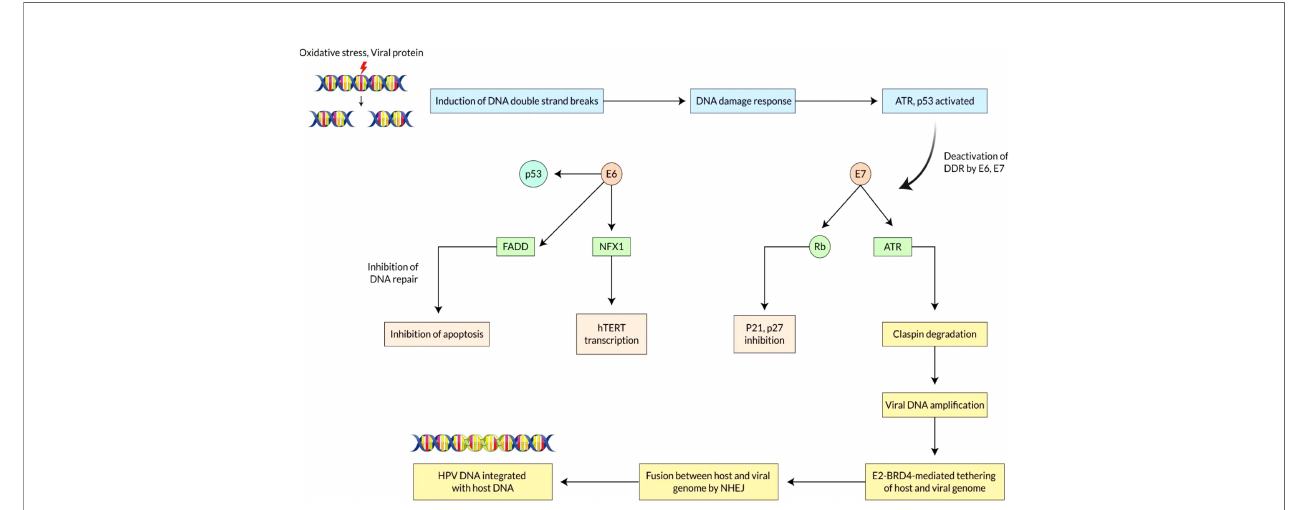
FIGURE 3 | Mechanisms of E6 and E7 overexpression due to integration of Human Papilloma Virus in Vaginal cancer. Vaginal cancer is a multi-stage process that is developed by the accumulation of DNA changes of host cell genes. Integrating HPV DNA into the host cell genome is crucial, resulting in abnormal proliferation and development. E6 and E7 genes play a crucial role in interfering with the tumor suppressor gene ’ s function. The continued action of proteins E6 and E7 causes abnormal cell proliferation, mutation of the oncogene, and eventually vaginal cancer. The integration site is dispersed over the entire genome as chromosomally fragile areas where DNA cracks in double strands are not repaired. HPV DNA breaks are initiated when the virus is replicated, and these breaks cannot be remedied. When CDKs inhibitors (P21, P27) and P53 protein are inhibited, E6 and E7 oncoproteins damage the checkpoint of the cell cycle. DNA damaging reaction pathways regulate fusion between the two genomes by homologous or heterologous recombination. HPV genome directly binds to the host chromosome via HPVE2-BRD4 complex for dividing genomes into daughter